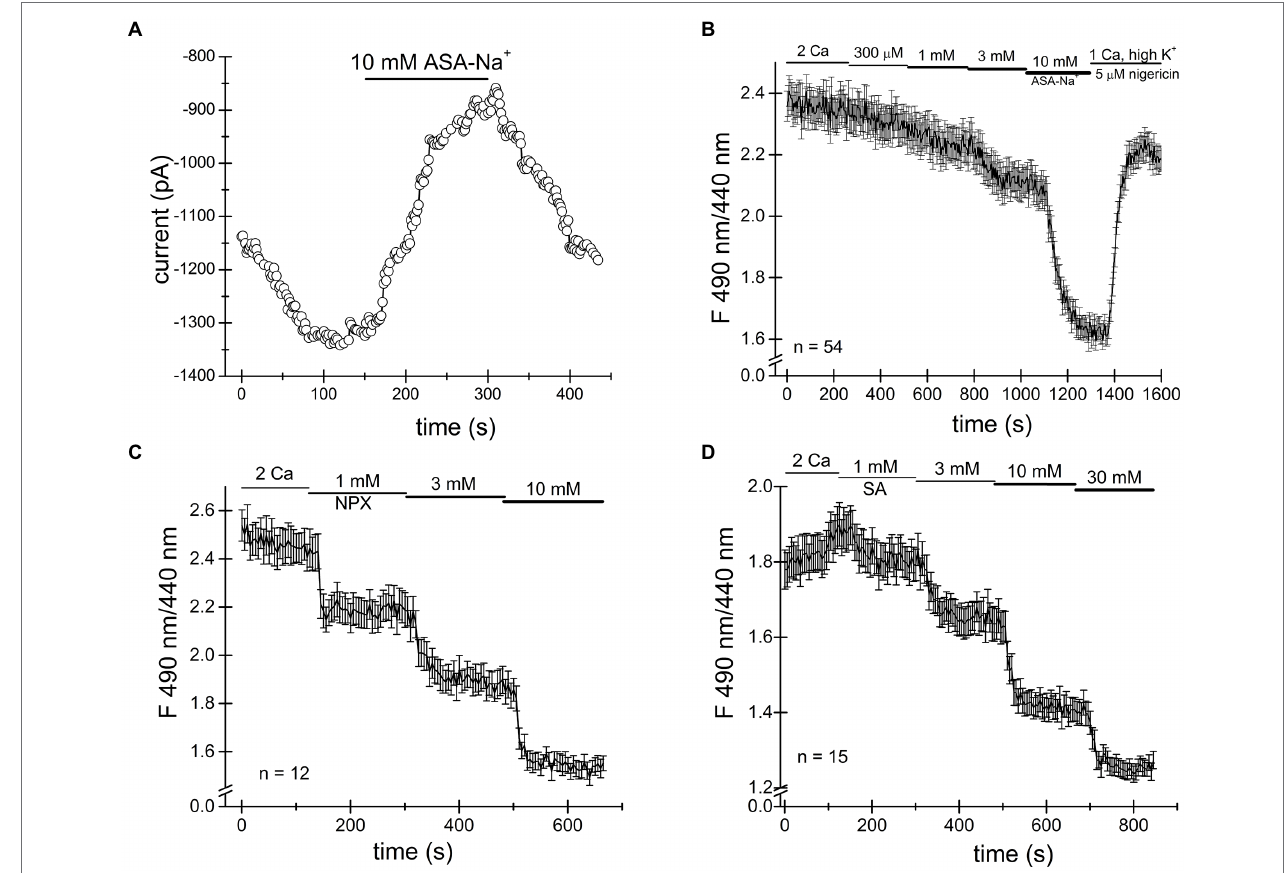
FIGURE 5 | Cytosolic acidification caused by NSAIDs does not require COX enzymes. (A) Acetylsalicylate inhibits TRPM7 current in Jurkat T cells reversibly. (B) Acidification in Jurkat T cells induced by acetylsalicylate is reversible. Naproxen (C) and ibuprofen (D) acidify Drosophila S2 cells.